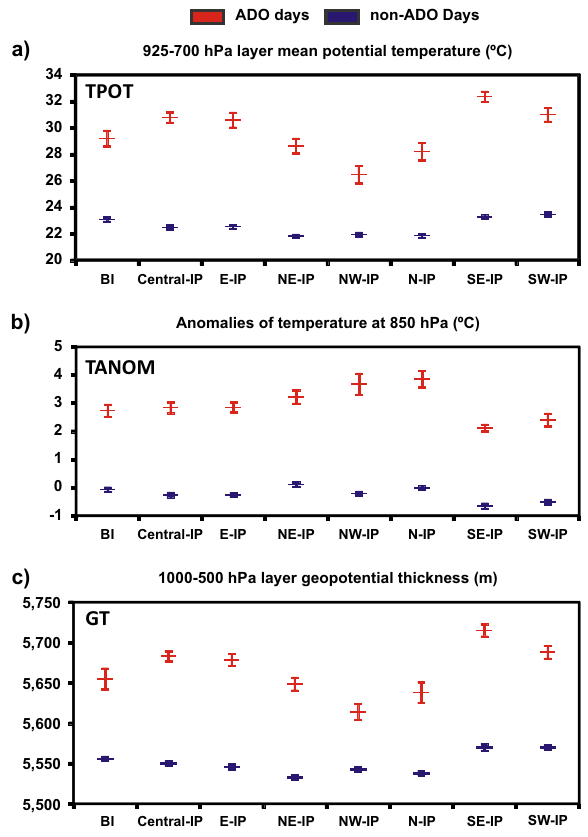
Fig. 2 Impact of ADO on thermodynamic parameters. Median values (and 95% con fi dence intervals) of TPOT ( a ), TANOM ( b ), and GT ( c ) over each of the 8 regions of study during ADO days and days without dust contribution (non-ADO) in the period 2001 – 2020. BI Balearic Islands, IP Iberian